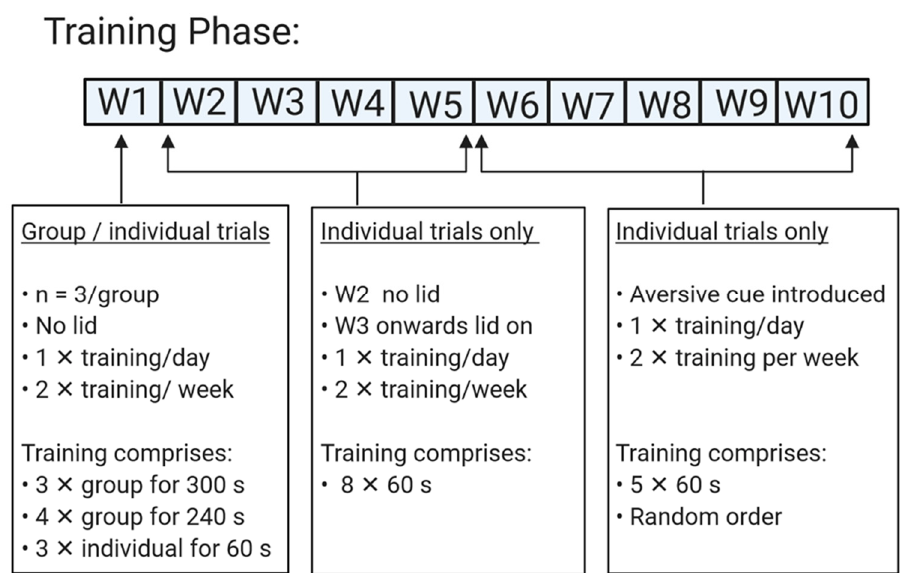
Figure 3. Indicates simple timeline of training protocol for spatial go/no go task where pigs were trained for a ten-week period in both group and individual trials.